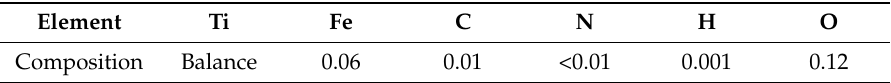
Table 1. Chemical composition of used commercial pure (CP)-titanium (wt. %).